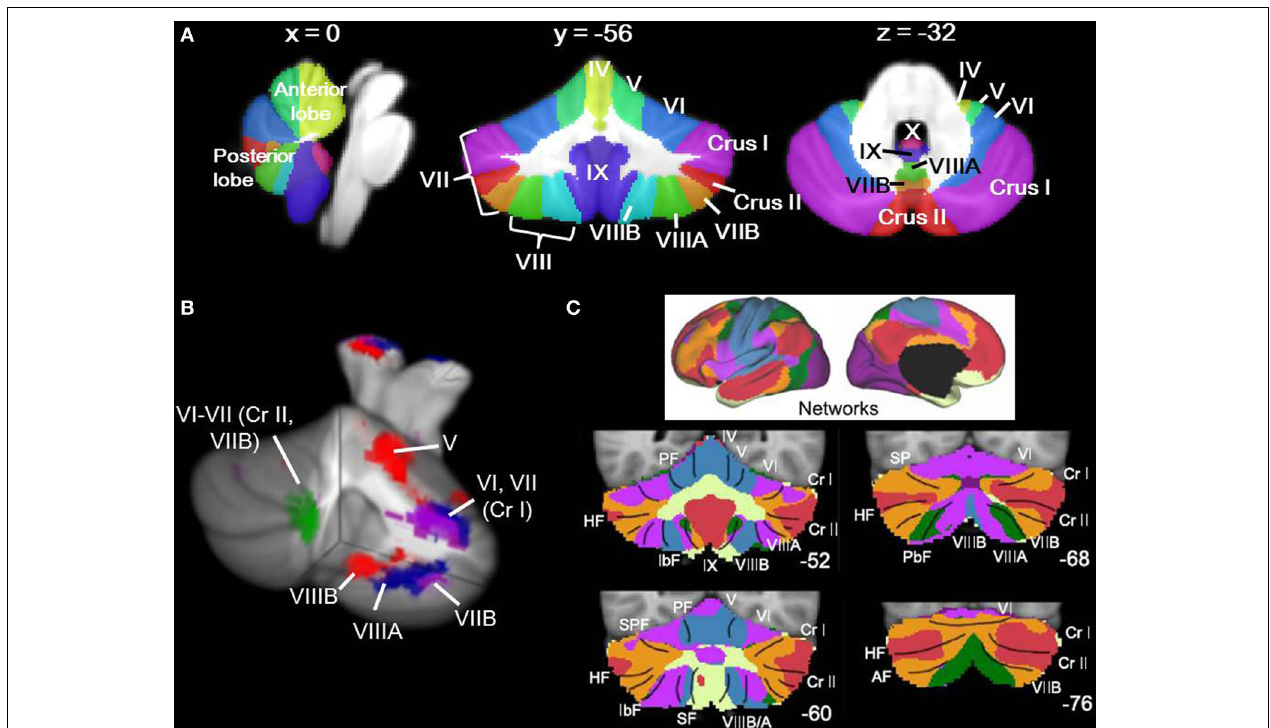
FIGURE 1 | Cerebellar anatomy and functional topography. (A) Cerebellar anatomy shown on coronal, sagittal, and axial slices through the Spatially Unbiased Infratentorial (SUIT) atlas (Diedrichsen, 2006; Diedrichsen et al., 2009). The cerebellum is subdivided into three lobes (anterior, posterior, and flocculonodular [lobule X]) and 10 lobules (I-X). In humans, lobule VII is subdivided into Crus I, Crus II, and VIIB, and lobule VIII is divided into VIIIA and VIIIB. Yellow, lobules I–IV; light green, lobule V; blue, lobule VI; purple, lobule VII (Crus I); red, lobule VII (Crus II); orange, lobule VII (VIIB); green,